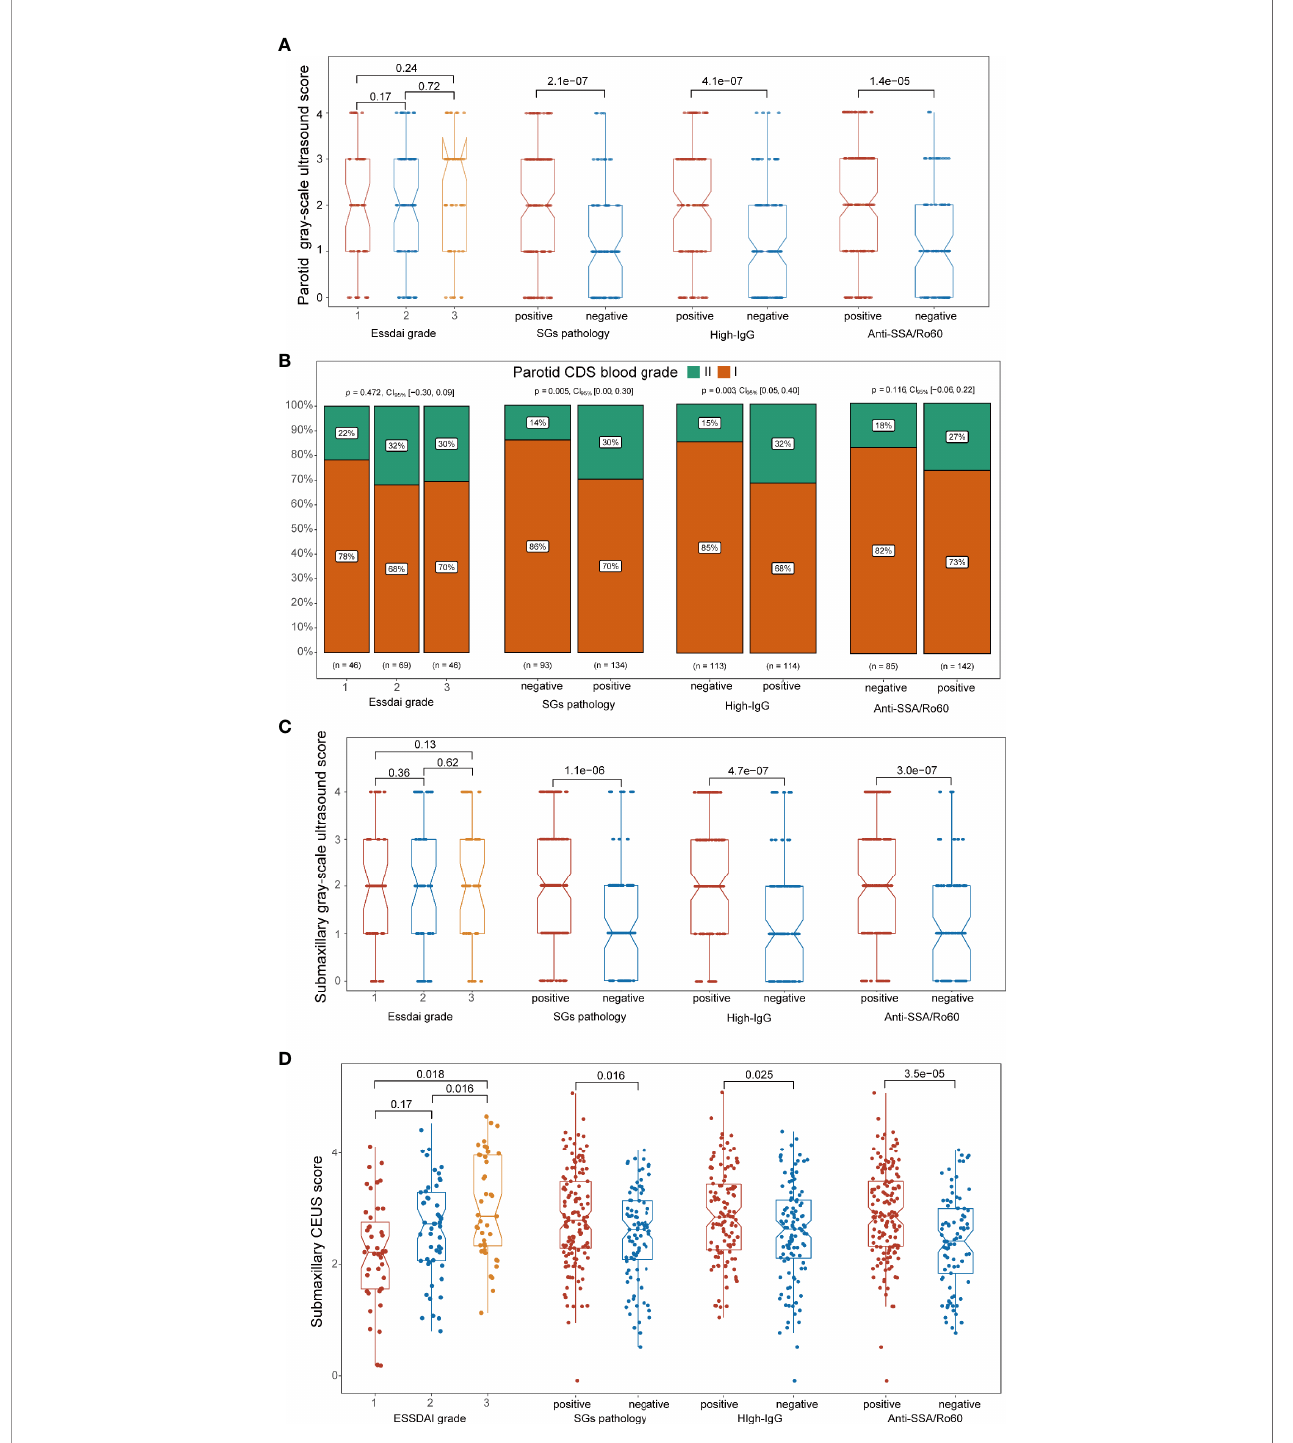
FIGURE 4 | Association between ultrasonographic signatures and signi fi cant clinical phenotypes of primary Sjögren ’ s syndrome (pSS). (A, C) In both the parotid and submandibular glands, the grayscale ultrasound (US) scores were higher in pathologically positive, high IgG-positive, and anti-SSA/Ro60-positive groups (p < 0.001) than their corresponding groups, while there was no signi fi cant correlation in ESSDAI grade groups. (B) Higher rate of CDS grade II in the parotid glands was found in the pathologically positive group (p = 0.005) and high-IgG groups (p = 0.003), while there was no signi fi cant difference between subgroups in ESSDAI and anti-SSA/Ro60 phenotypes (p > 0.05). (D) Higher CEUS scores in submandibular glands were found in the pathologically positive group (p = 0.016), high-IgG group (p = 0.025), anti-SSA/Ro60-positive group (p < 0.001), and higher ESSDAI grades (p <